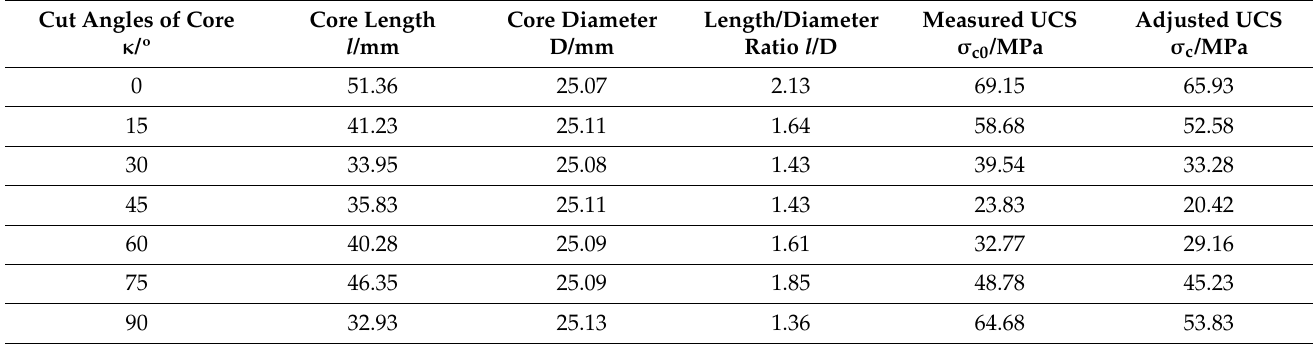
Table 1. Rock mechanical testing results of bedding